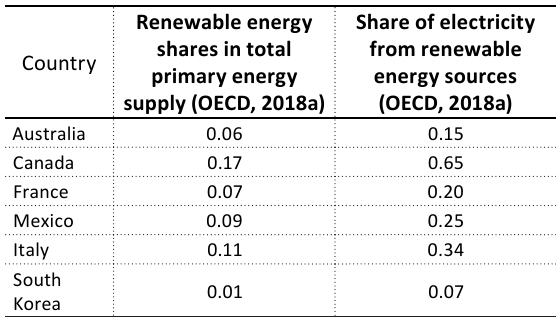
Table 6. Shares of renewable energy